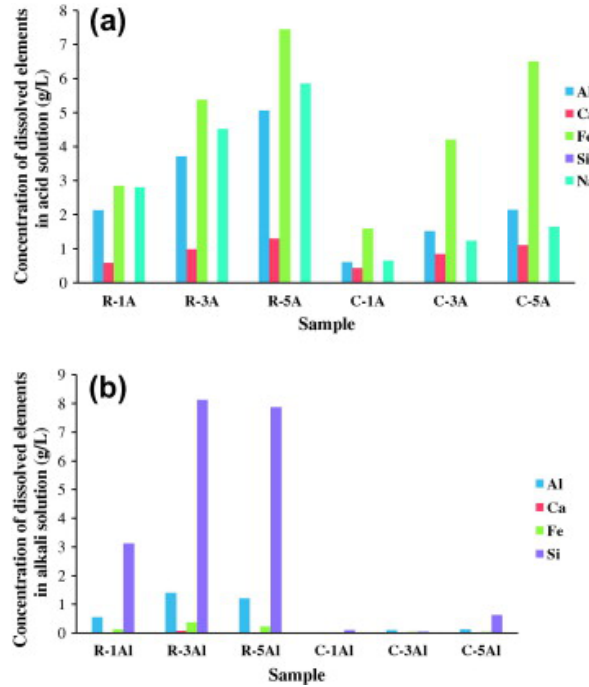
Figure 8: Concentration of elements dissolved from geopolymer samples, (a) in acid solution; (b) in alkali solution [64]